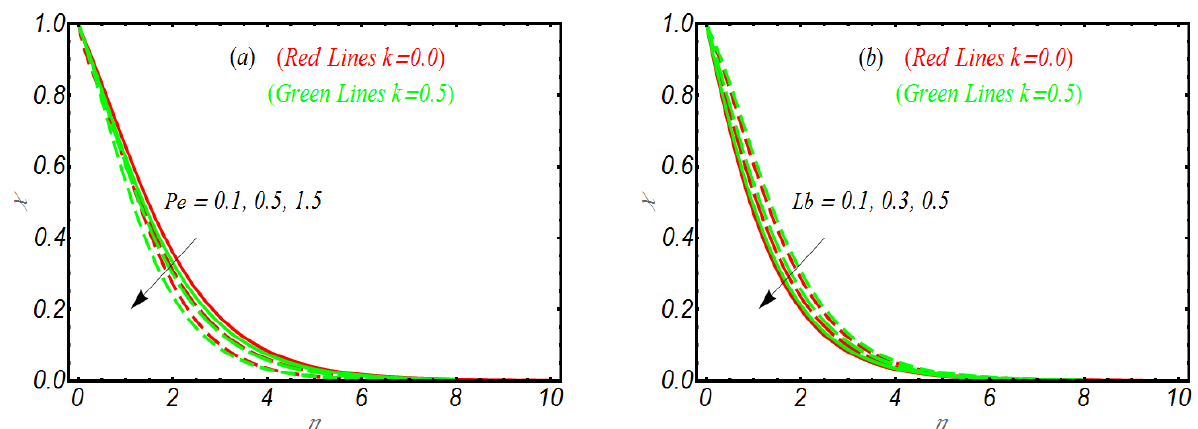
Figure 5. Microorganism profile for ( a ) P e , ( b ) Lb